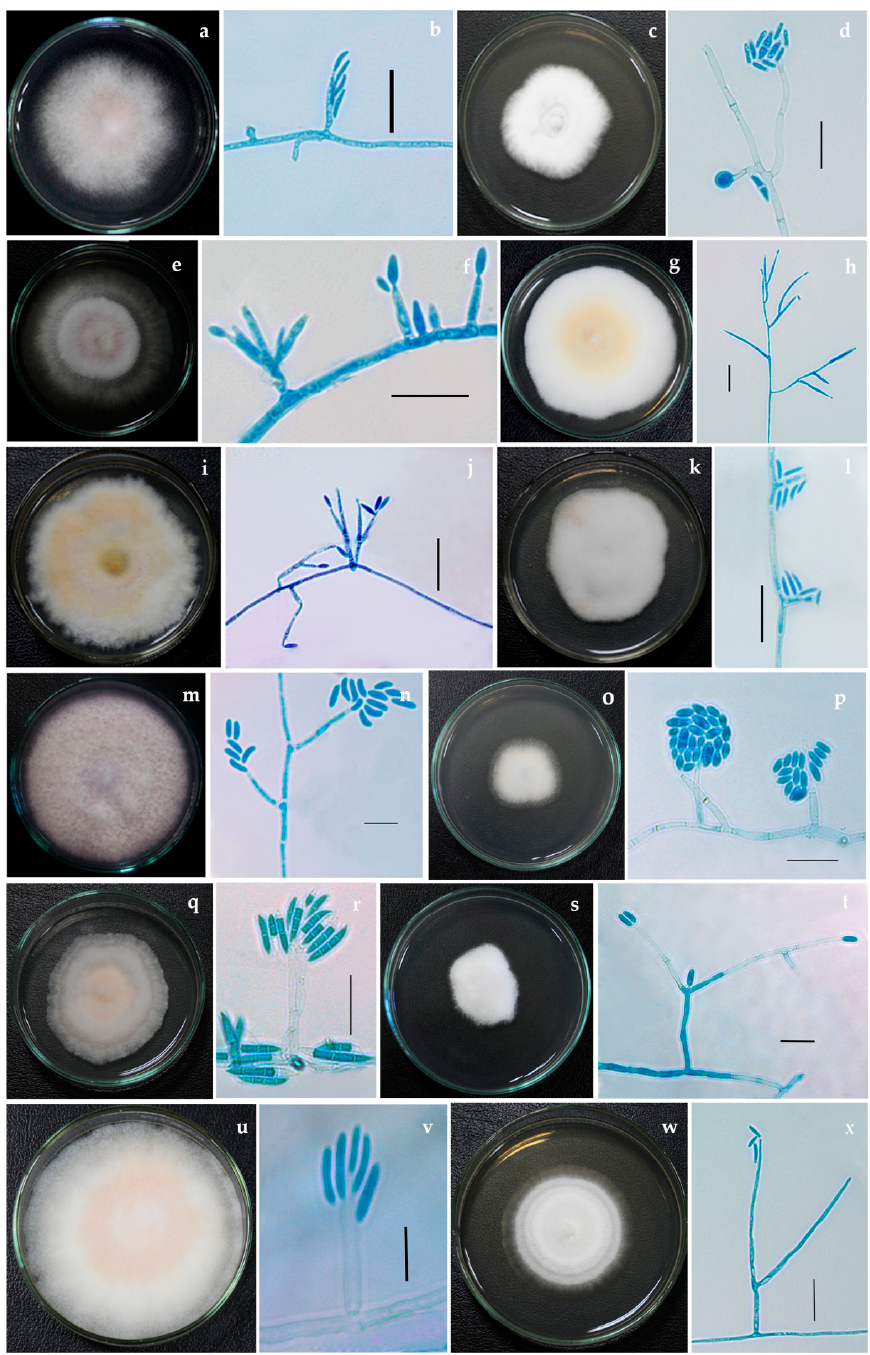
Figure 1. Fusarium isolates with phialides bearing conidia ( a , b ) Fusarium nirenbergiae NFCCI 5189 ( c , d ) Neocosmospora solani NFCCI 2315 ( e , f ) F. mangiferae NFCCI 2885 ( g , h ) F. annulatum NFCCI 2962 ( i , j ) F. microconidium NFCCI 3020 ( k , l ) F. sacchari NFCCI 3147 ( m , n ) N. oblonga NFCCI 2150 ( o , p ) Albonectria rigidiuscula NFCCI 5202 ( q , r ) F. irregulare NFCCI 2460 ( s , t ) Neocosmospora suttoniana NFCCI 2961 ( u , v ) F. annulatum NFCCI 2964 ( w , x ) Neocosmospora vasinfecta NFCCI 2972. Scale bars: b, d, f, h, j, l, p, r, t, v, x = 20 µ m; n = 10 µ